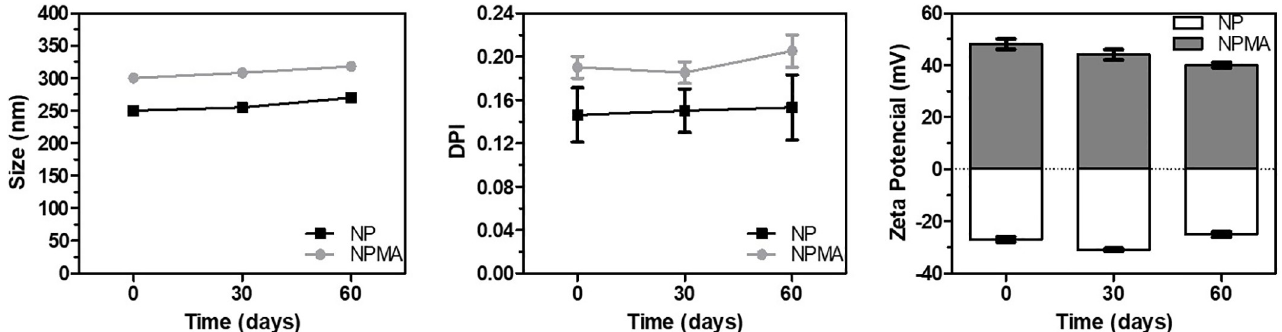
Fig 2. Colloidal stability of NPs and NPMAs. Colloidal parameters as size, PDI and zeta potential were evaluated as a function of time using the DLS technique (n = 3). All parameters were considered stable, indicating the suitability of the nanoformulations.